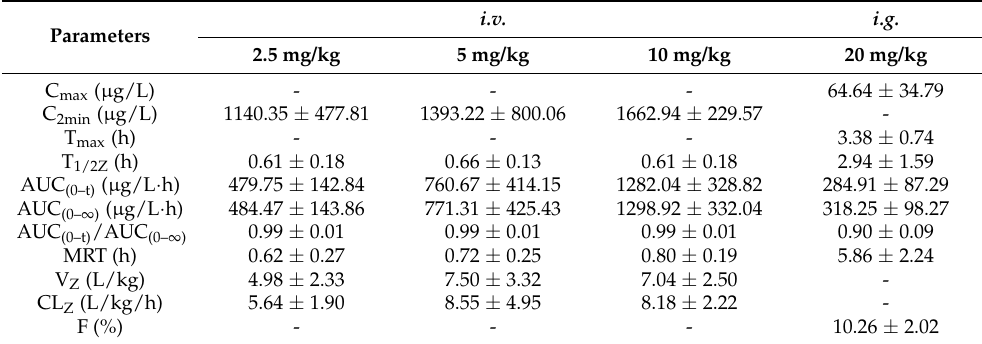
Figure 3. The mean plasma concentration-time curves of oxypeucedanin in log scale of ordinate ( n = 8): ( A ) i.v. administration of oxypeucedanin at 2.5, 5, and 10 mg/kg; and ( B ) i.g. administration of oxypeucedanin at 20 mg/kg. Table 5. The estimated mean pharmacokinetic parameters of oxypeucedanin after intravenous and oral administration ( n = 8).